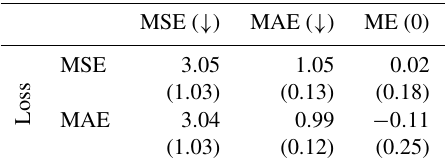
Table 2. Results for GRAINet regressing the mean diameter d m [cm]. Mean and standard deviation (in parenthesis) for the random 10-fold cross-validation. The rows correspond to the CNN models trained with the respective loss function. While both MSE and MAE are minimized ( ↓ ), the ME is optimal with zero bias